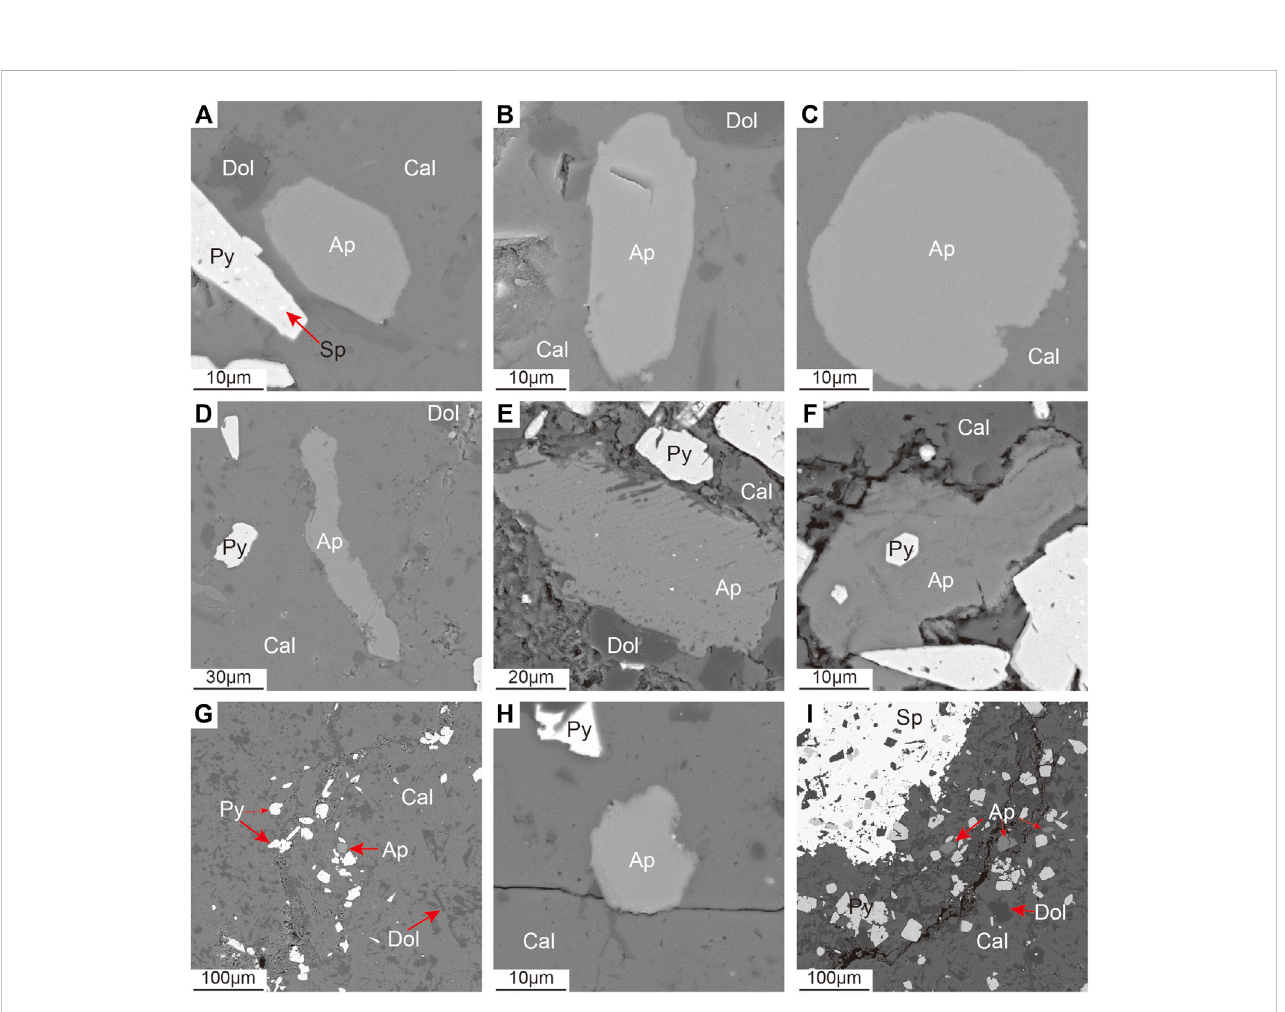
Back-scattered electron (BSE) photographs of apatite from the Huayuan Pb-Zn ore fi eld: (A) automorphic apatite; (B) hypidiomorphic apatite; (C) xenomorphic apatite; (D) xenomorphic apatite with fl ow structure; (E) hypidiomorphic-xenomorphic apatite with numerous fl uid inclusions; (F) pyrite inclusions in apatite; (G) apatite in veins with pyrite; (H) apatite cutting fi ssures formed by diagenesis; and (I) apatite and pyrite distributed around